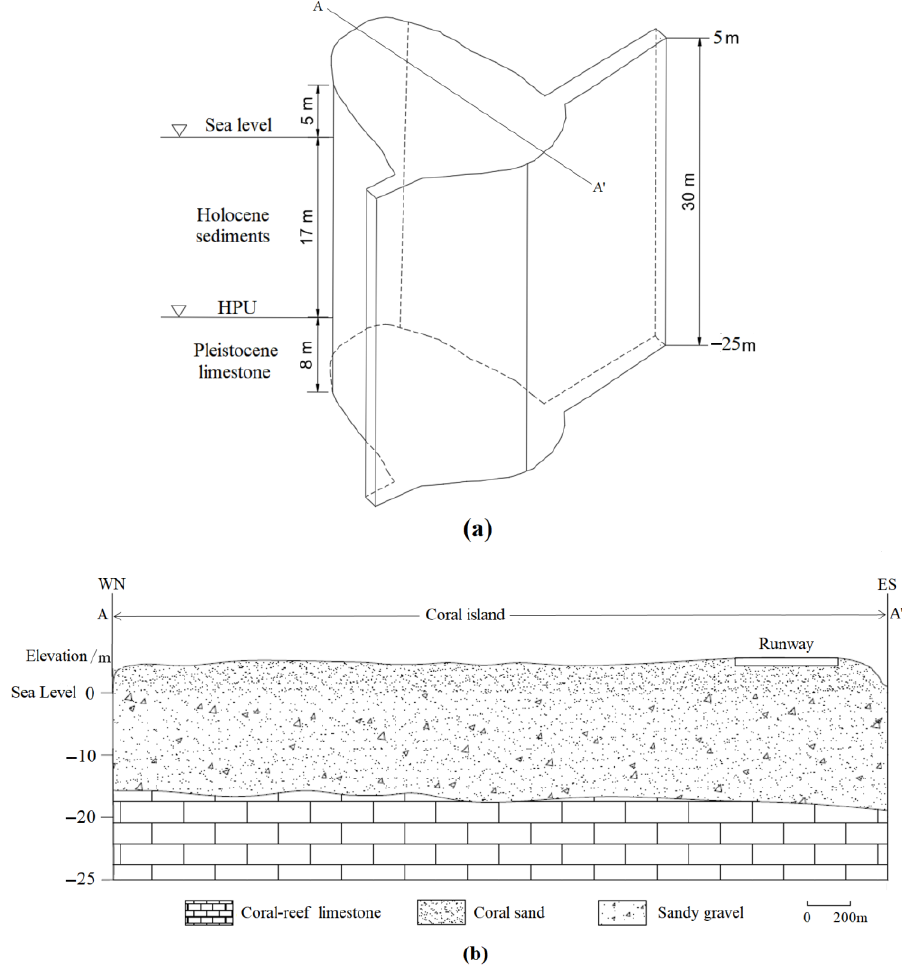
Figure 1. Hydrogeological conceptual model: ( a ) Schematic diagram of model simulation range; ( b ) hydrogeological structure of profile A – A ’ .